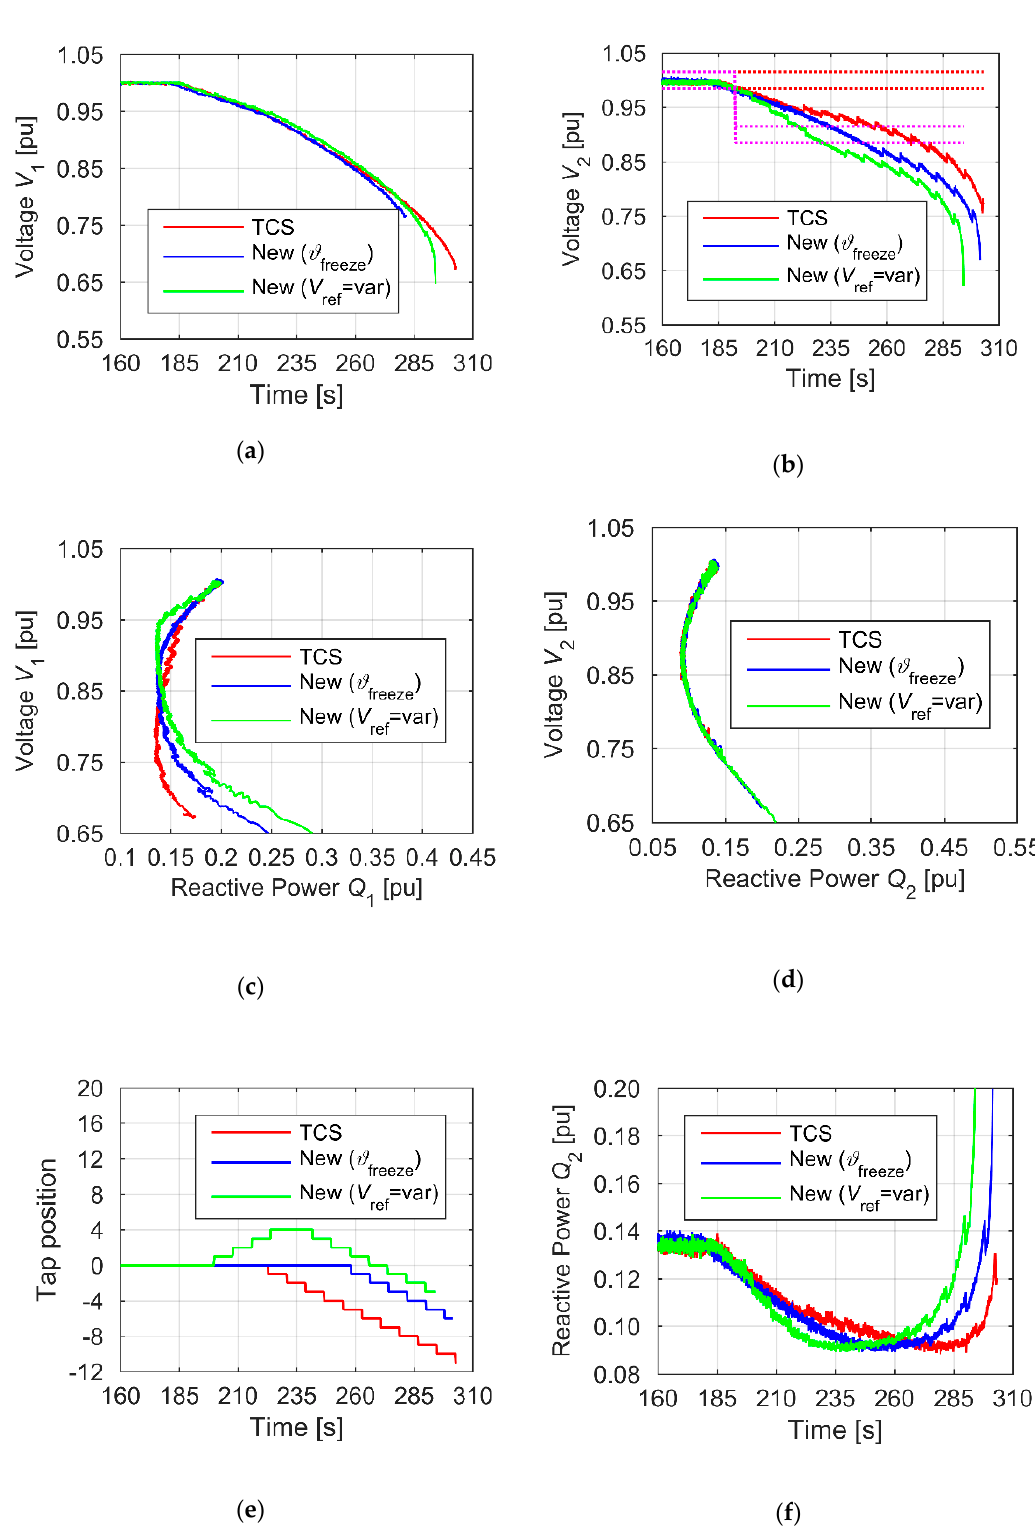
Figure 17. Verification of the effectiveness of the proposed algorithm, tests on the physical model—variant C: ( a ) voltage V 1 ; ( b ) voltage V 2 ; ( c ) characteristics V 1 = f( Q 1 ); ( d ) characteristics V 2 = f( Q 2 ); ( e ) tap position; ( f ) reactive power Q 2 .